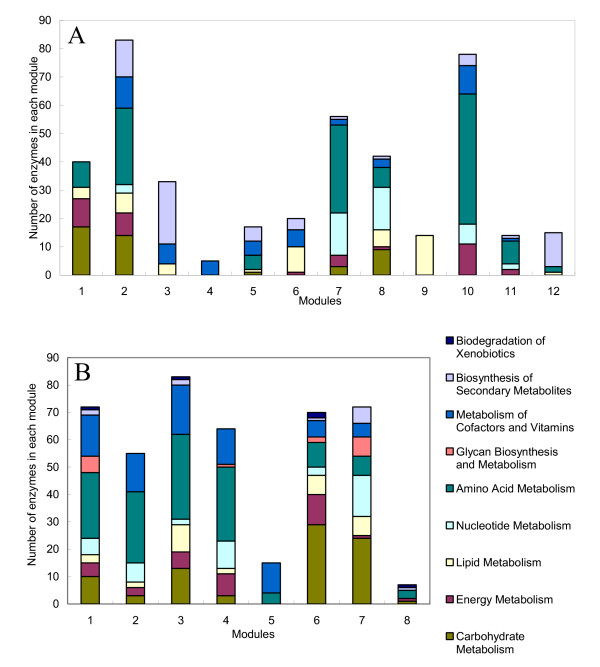
Comparison of functional modules in chloroplasts and cyanobacteria. (A) Chloroplast enzyme modules; (B) Synechococcus sp. WH8102 (syw) enzyme modules map according to KEGG classification.